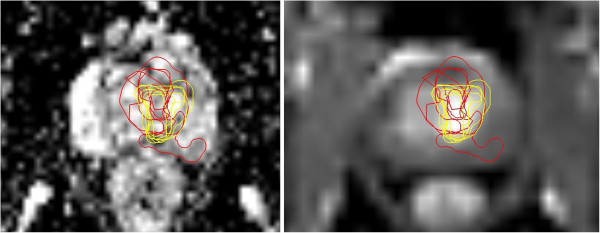
(Patient No. 3). Transversal slices through the middle of the prostate; left = DWI-, right = DCE-sequence. Left: DWI based GTV-delineation (red contours). Right: DCE based GTV-delineation (yellow contours). T2w-GTV-contours are not depicted for better survey.